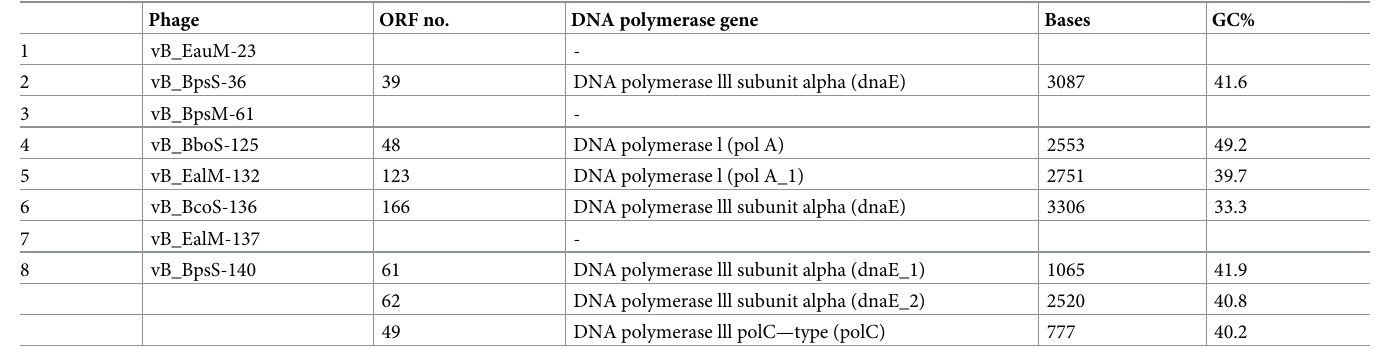
Table 3. Replication factor DNA polymerase in the eight